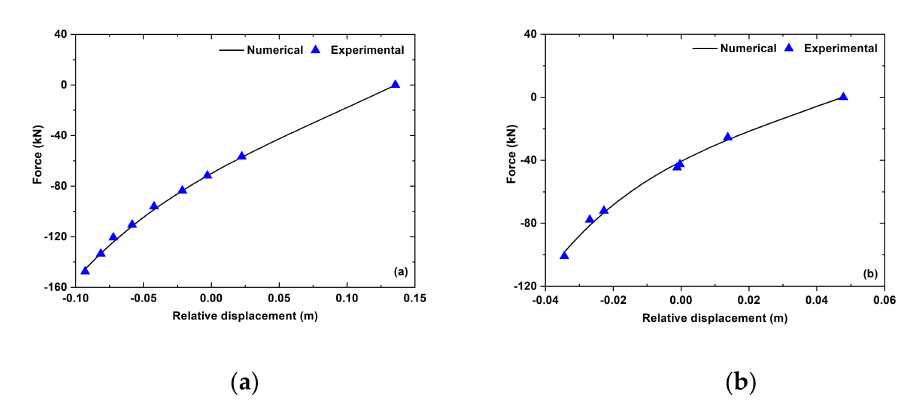
Figure 4. ( a ) Primary and ( b ) secondary vertical suspension spring characteristics.